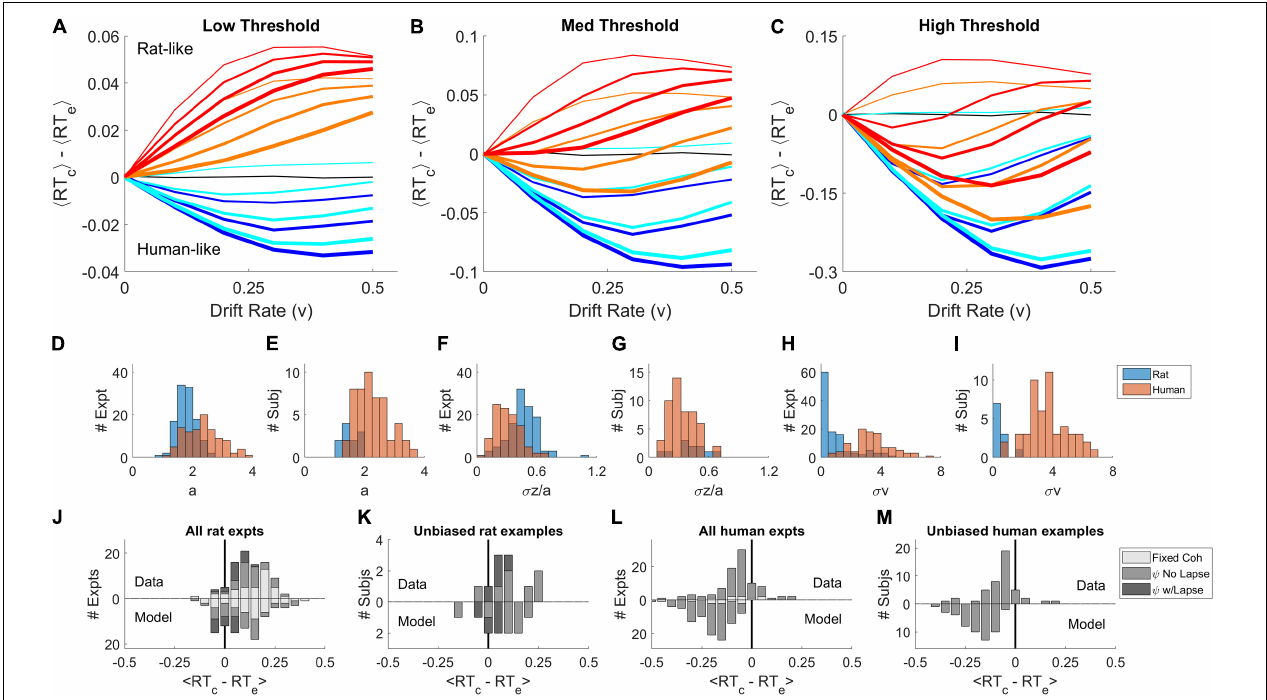
FIGURE 3 | Parameter sweep of the variable-parameter DDM. (A–C) Curves show the difference between correct and error mean response times, (cid:104) RT correct (cid:105) − (cid:104) RT error (cid:105) , as a function of drift rate parameter v = [ 0 . 0 , 0 . 1 , 0 . 2 , 0 . 3 , 0 . 4 , 0 . 5 ] . Colors indicate starting point variability σ z = [ 0 . 0 , 0 . 02 , 0 . 07 , 0 . 10 ] , in spectral order from low (dark blue) to high (red). Line thickness indicates drift rate variability σ v = [ 0 . 0 , 0 . 08 , 0 . 12 , 0 . 16 ] . Black curve is for σ v = 0, σ z = 0. (A) Simulations with threshold separation a = 0 . 08. (B) Simulations with a = 0 . 11. (C) Simulations with a = 0 . 16. For all the simulations shown, z = 0, t = 0 . 3, σ t = 0 . 2, τ = 0 . 001, and σ n = 0 . 1. (D) Distribution of threshold separation a from fits of this model to datasets from Reinagel and Shevinsky (2020). (E) Distribution of a among example psychometric experiments from unique unbiased subjects in those datasets (see section “Materials and Methods”). (F) Distribution of starting point variability, expressed as a fraction of threshold separation: σ z / a . (G) Distribution of σ z / a in the unbiased example sets. (H) Distribution of drift rate variability σ v . (I) Distribution of σ v in the unbiased example sets. (J) Average difference between correct and error response times (cid:104) RT c − RT e (cid:105) computed locally within coherence, averaged over coherences ≥ 0.4. Fixed coherence (light), psychometric with < 10% lapse (medium) or with ≥ 10% lapse (dark). Upward bars show the results from the rat dataset, as analyzed in Shevinsky and Reinagel (2019); N = 51 psychometric, N = 38 fixed-coherence experiments had sufficient trials for this analysis. Lower bars show results for trial data simulated by the models ( N = 58 psychometric and N = 39 fixed). (K) Like (J) , but for the rat unbiased example subset; N = 11 data or models. (L) Like (J) but for human dataset ( N = 81 psychometric, N = 9 fixed) and models fit to human dataset ( N = 93 psychometric, N = 9 fixed), averaged over coherences ≥ 0.04. (M) Like (L) but for the human unbiased example subset, N = 45 (data) or N = 51 (model). For descriptive statistics see